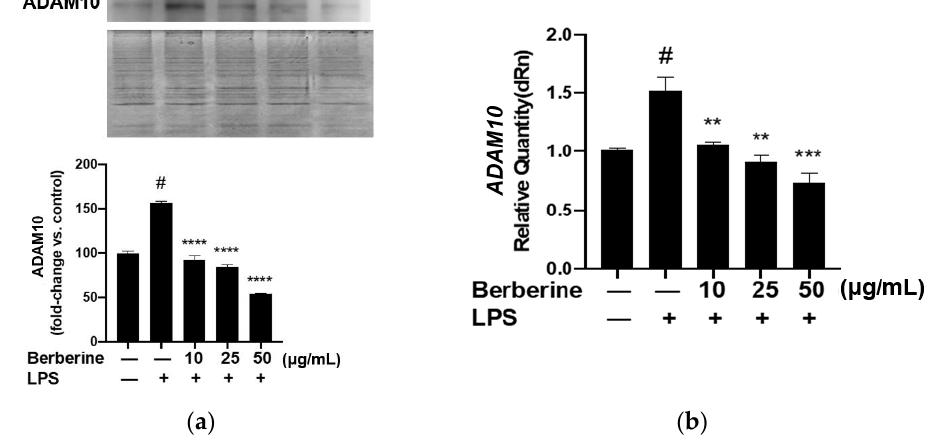
Figure 6. Berberine mitigated the lipopolysaccharide (LPS)-induced upregulation of membrane ADAM10 mRNA and protein expression levels in human umbilical vein endothelial cells. ( a ) Cells were pretreated with 10, 25, or 50 µg/mL berberine for 1 h, followed by stimulation with 5 µg/mL LPS for 4 h. The membrane expression of ADAM10 was analyzed using Western blotting (upper panel). Coomassie blue staining revealed that the protein amounts were equal in different samples (lower panel). Densitometric analysis data are shown in the bar graph (mean ± standard error of mean). ( b ) Cells were treated as in ( a ). Total RNA was isolated and subjected to quantitative real-time polymerase chain reaction analysis. GAPDH was used as an internal control. # p < 0.001 compared with the control group; ** p < 0.01 compared with the LPS group; *** p < 0.001 compared with the LPS group; **** p < 0.0001 compared with the LPS group.